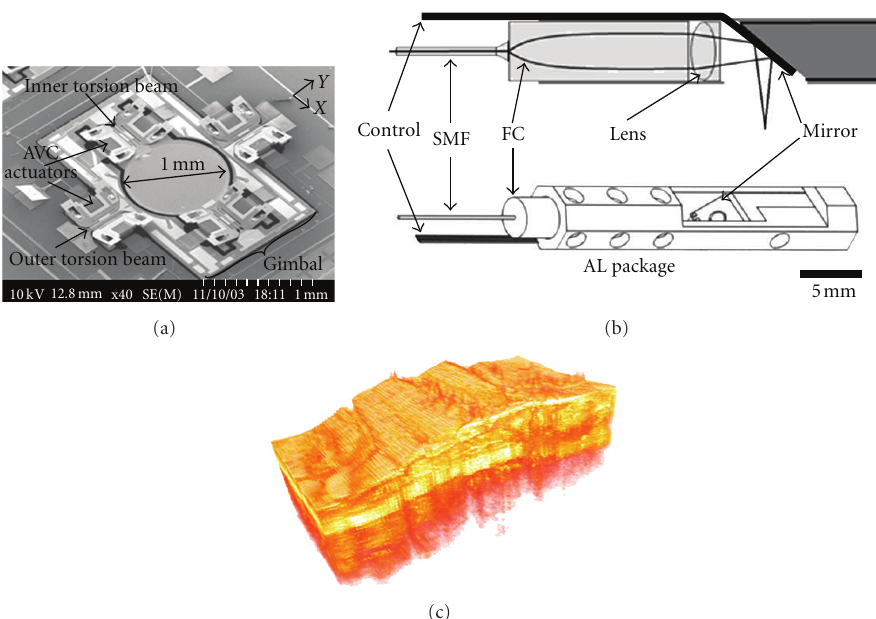
Figure 4: Electrostatic MEMS OCT from MIT. (a) SEMs of the MEMS mirror with angled vertical comb (AVC) actuators. (b) design and packaging of the probe. SMF, single mode fiber. FC, fiber collimator. AL, aluminum. (c) 3D image of hamster cheek pouch. Reprint permission granted by